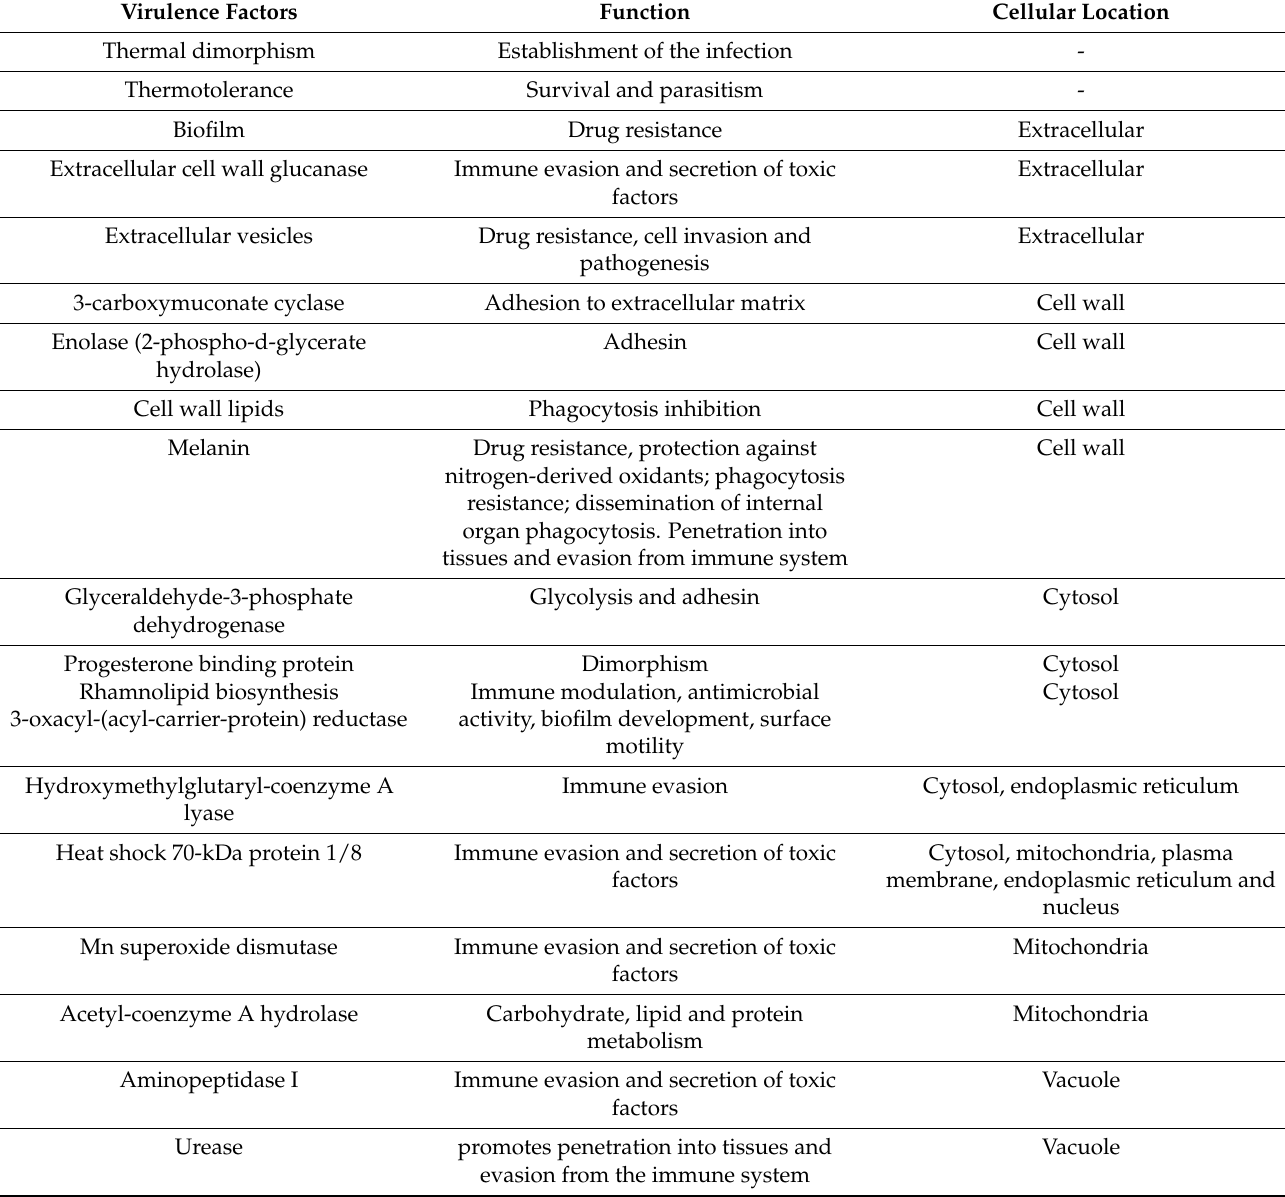
Table 3. Virulence factors of S.